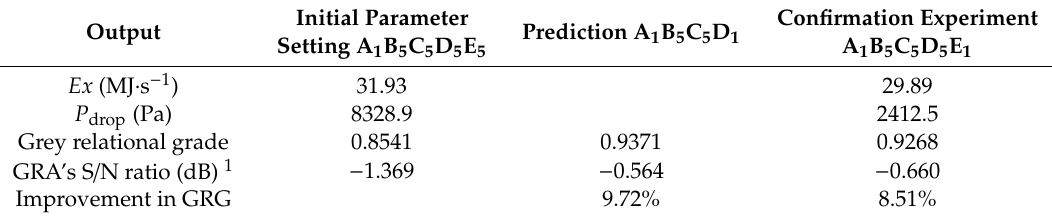
Table 15. Confirmation test for